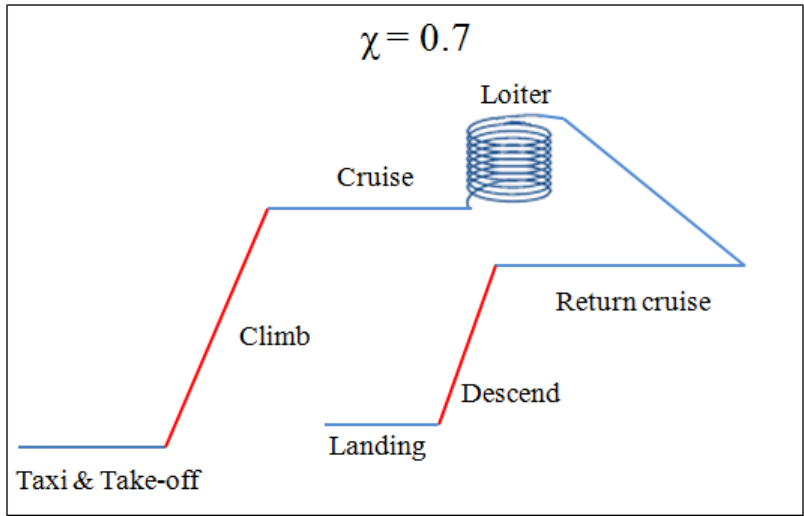
Figure 3. Mission profile of a surveillance